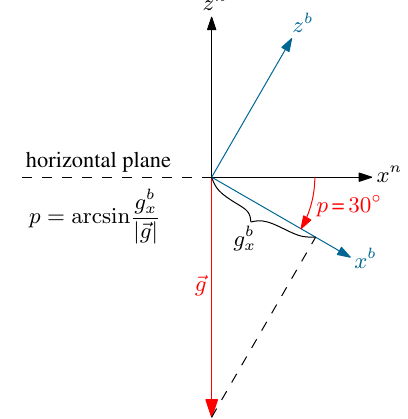
Figure 4: By measuring the components of the gravitational ac- celeration (cid:126)g with the accelerometers, the tilt angles roll and pitch can be